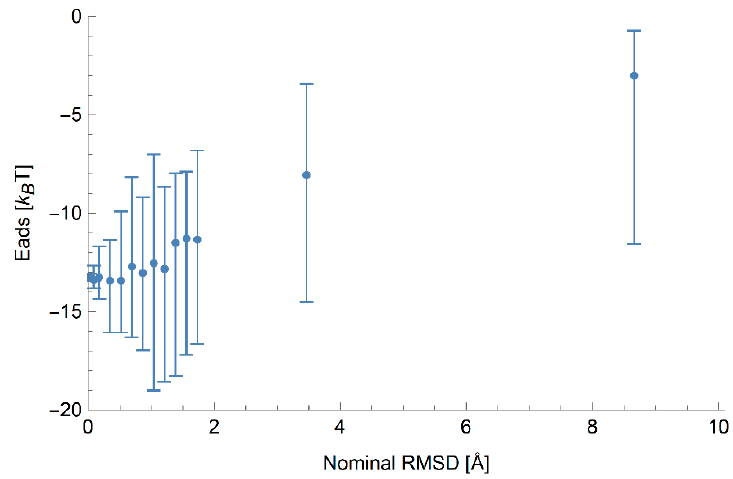
Figure 1. Predicted adsorption energy of 1AX8 on anatase NPs of radius 5 nm as a function of the root-mean-square deviation (RMSD) for a set of generated structures based on the PDB structure of this protein with perturbations applied to the location of each residue. The points indicate the mean binding energy of 30 structures with a specified typical RMSD, and the error bars indicate the full range of values of observed binding energies.